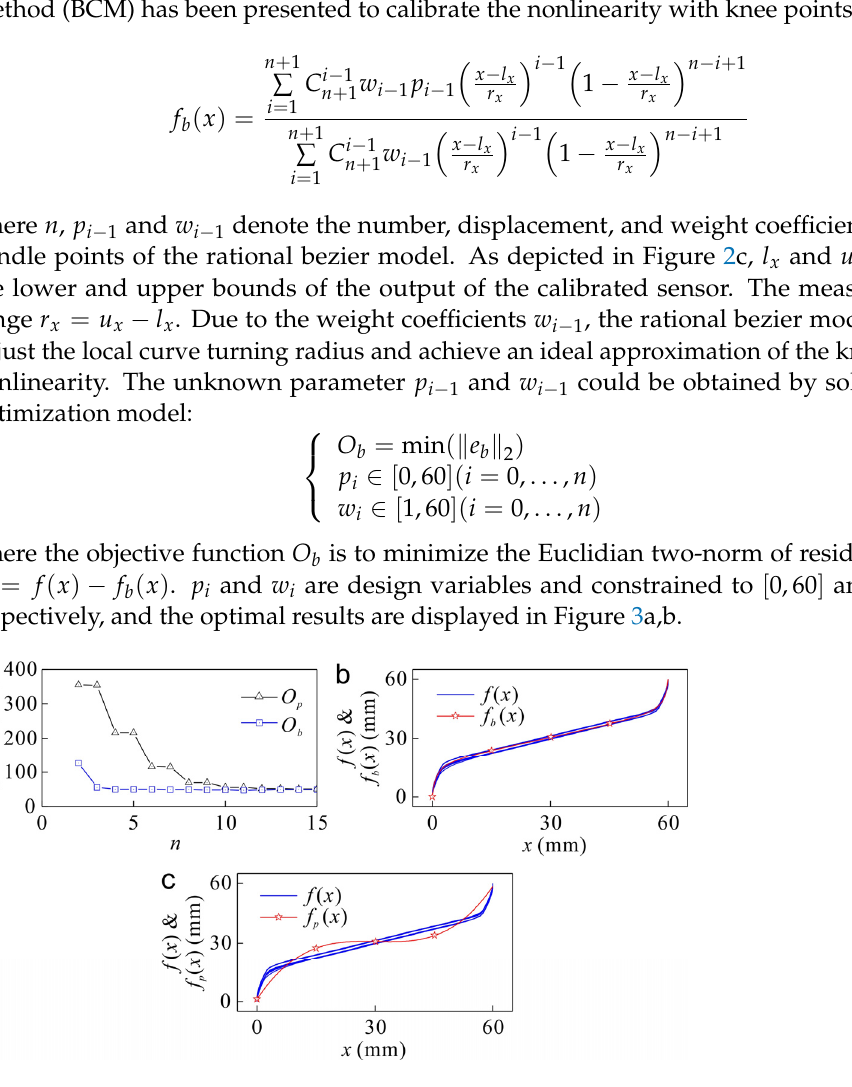
Figure 3. Calibration results of the inherent nonlinearity of the linear potentiometer. ( a ) Calibration efficiency comparisons between BCM and PCM by optimal objective functions O b and O p with respect to different model order n . ( b ) Comparison between the conventional true value f ( x ) and third-ordered BCM calibration f b ( x ) . ( c ) Comparison between the f ( x ) and third-ordered PCM calibration f p ( x ) .